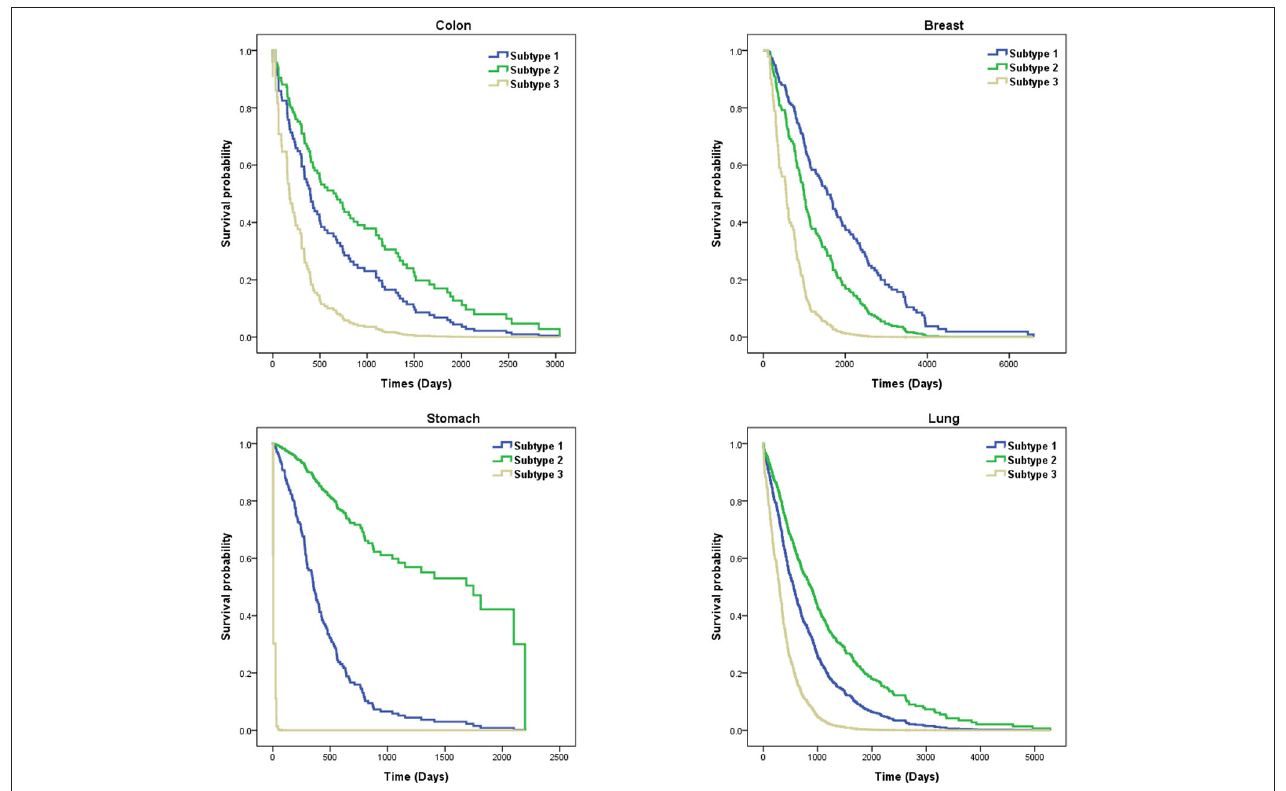
FIGURE 4 | Survival curves of subtypes for four